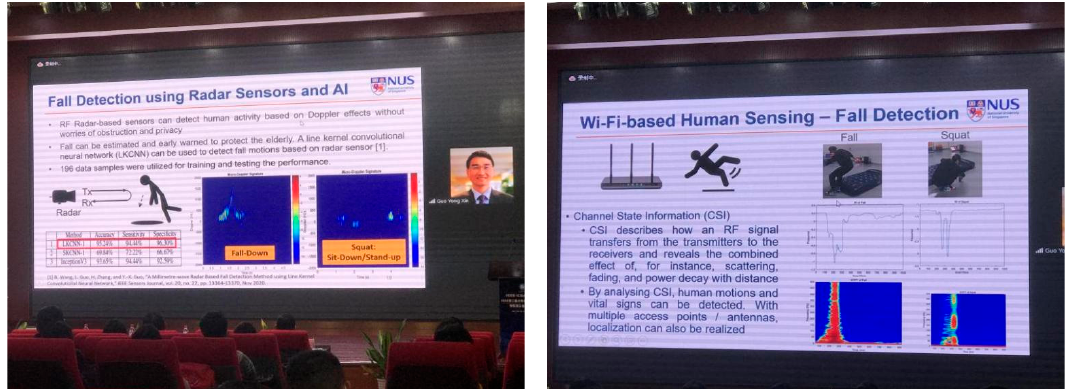
Figure 1. The speech of Professor Guo Yong-xin: Fall Detection using Radar Sensors for the old.